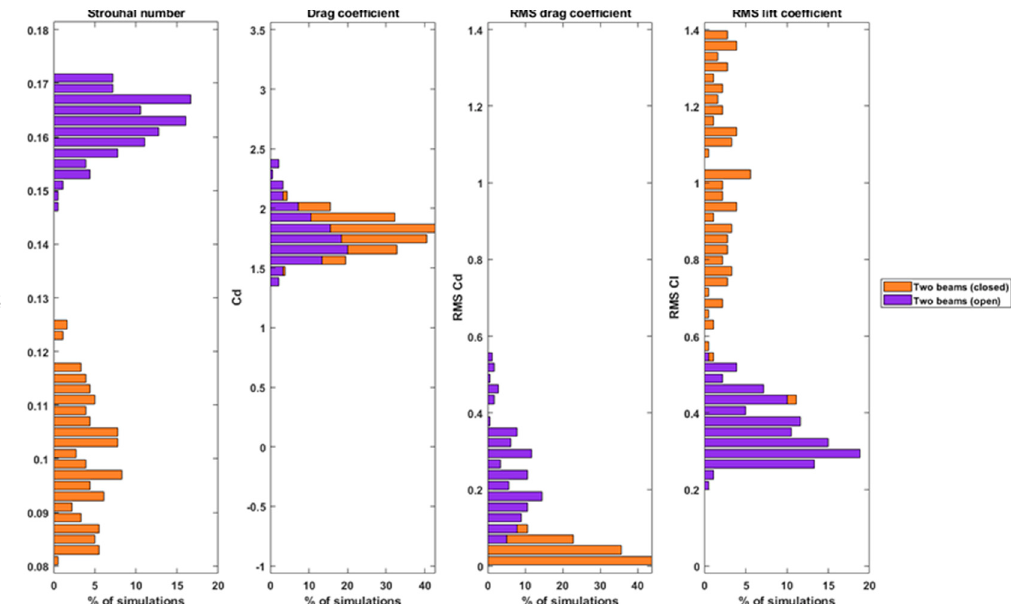
Figure 11. Distribution of the Strouhal number, drag coefficient, and Root Mean Square Figure 12. Distribution of the Strouhal number, drag coefficient, and Root Mean Square values of the drag and lift coefficients values of the drag and lift coefficients with and without the wooden/steel slabs isolat- with and without the wooden/steel slabs isolating the space between beams (double column, B&W in the printed ing the space between beams (double column, B&W in the printed version).